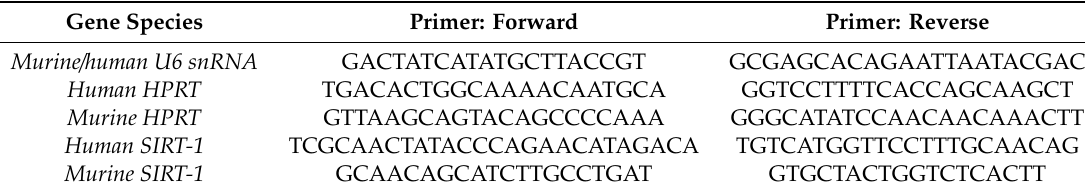
Table 1. Primers for